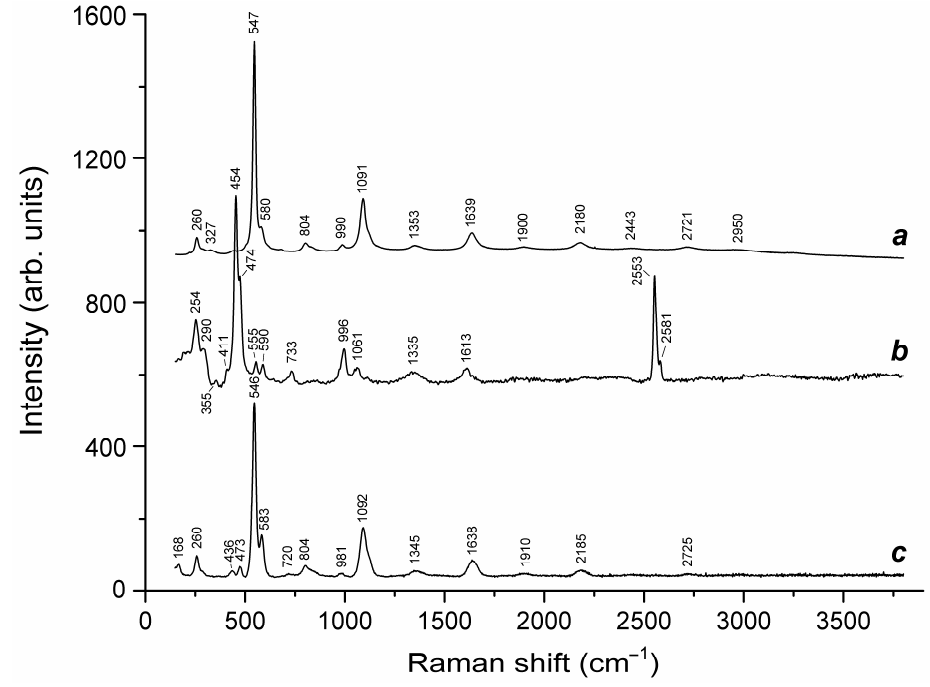
Figure 9. Raman spectra of ( a ) initial Sample 2, ( b ) Sample 2 preheated for three days at 700 ◦ C, over the Fe-FeS buffer, and ( c ) preheated Sample 2 additionally annealed at 800 ◦ C in air for one day.